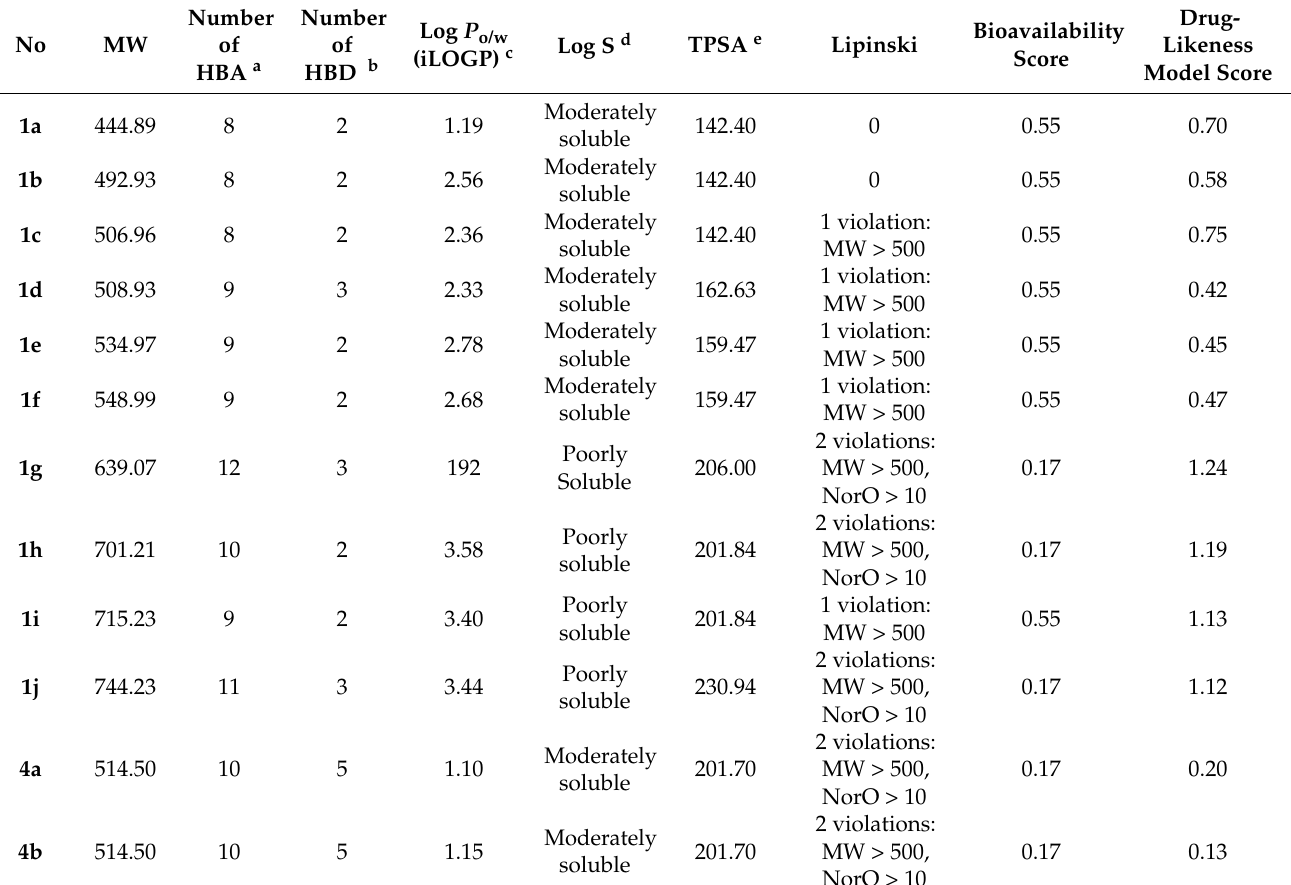
Table 4. Drug likeness predictions of tested compounds.